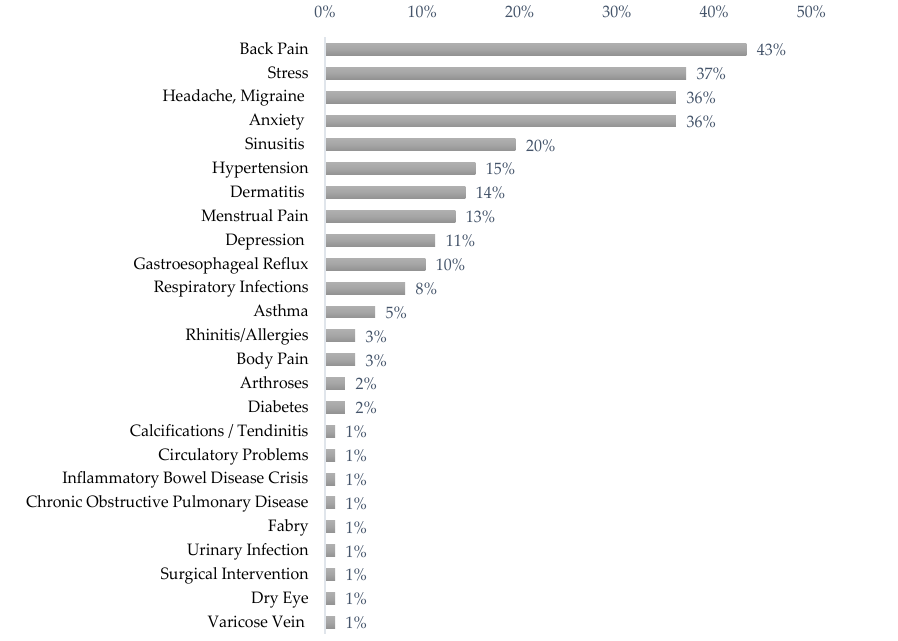
Figure 1. Prevalence of common health problems reported by presenteeist participants.